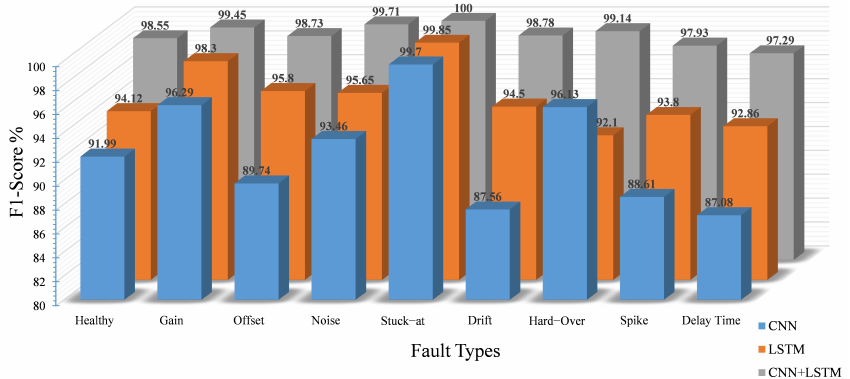
Figure 14. Classification performance in terms of F1-score.